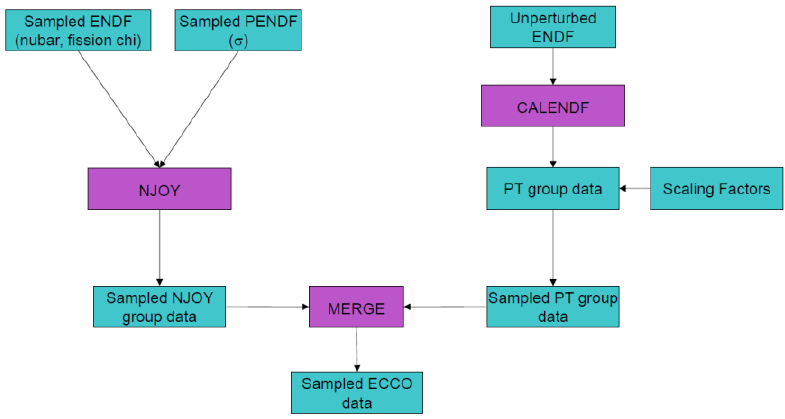
Figure 1. WIMS fast reactor perturbed nuclear data library generation